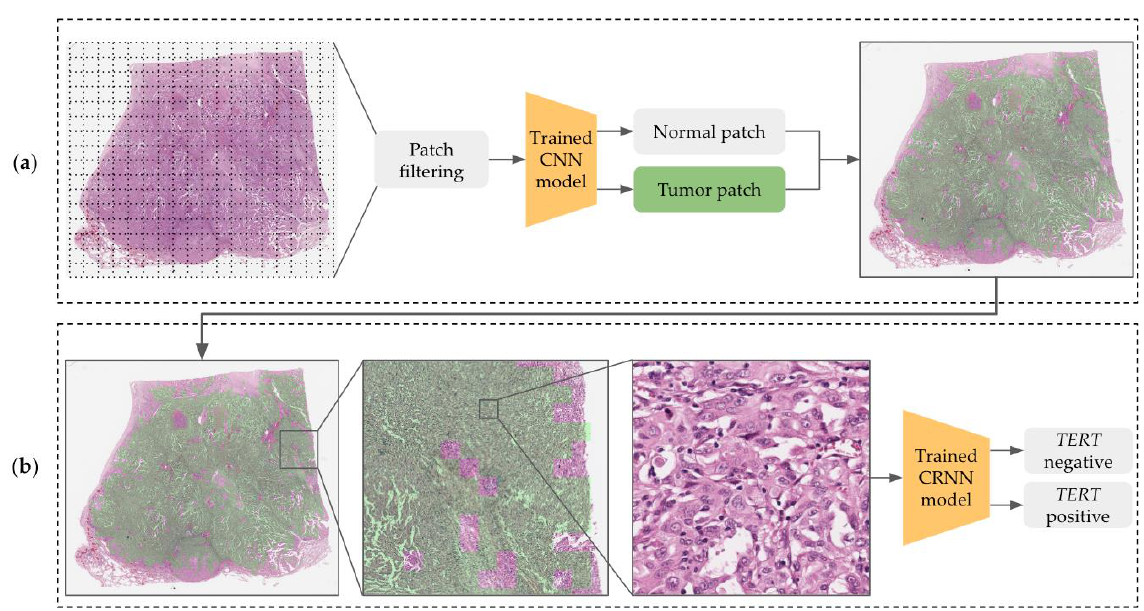
Figure 3. Overview of the TERT prediction architecture consisting of ( a ) a tumor classifier and ( b ) a mutation predictor.